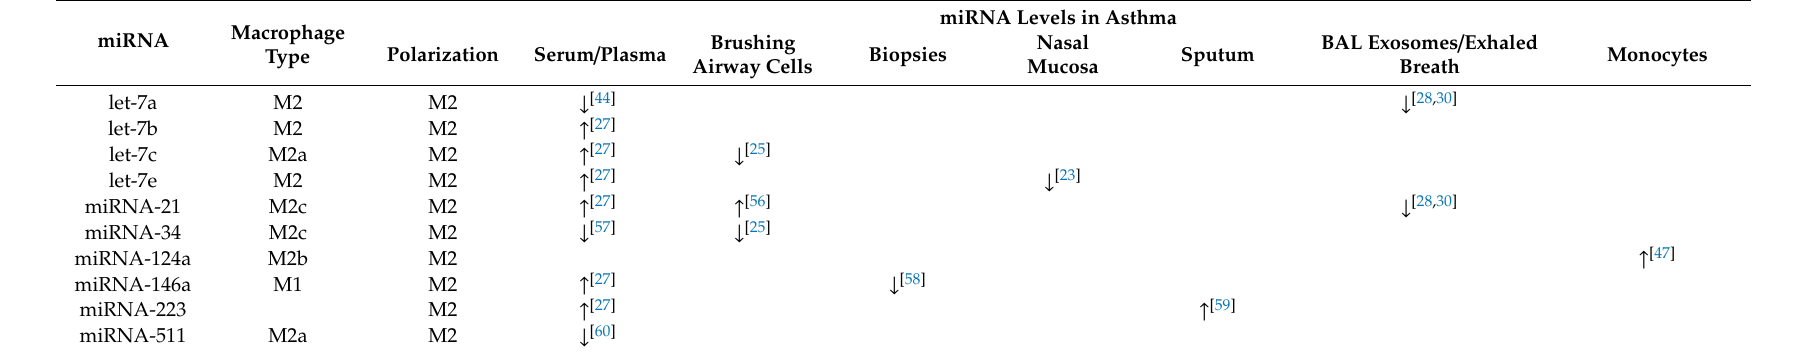
Table 2. Anti-inflammatory miRNA levels in